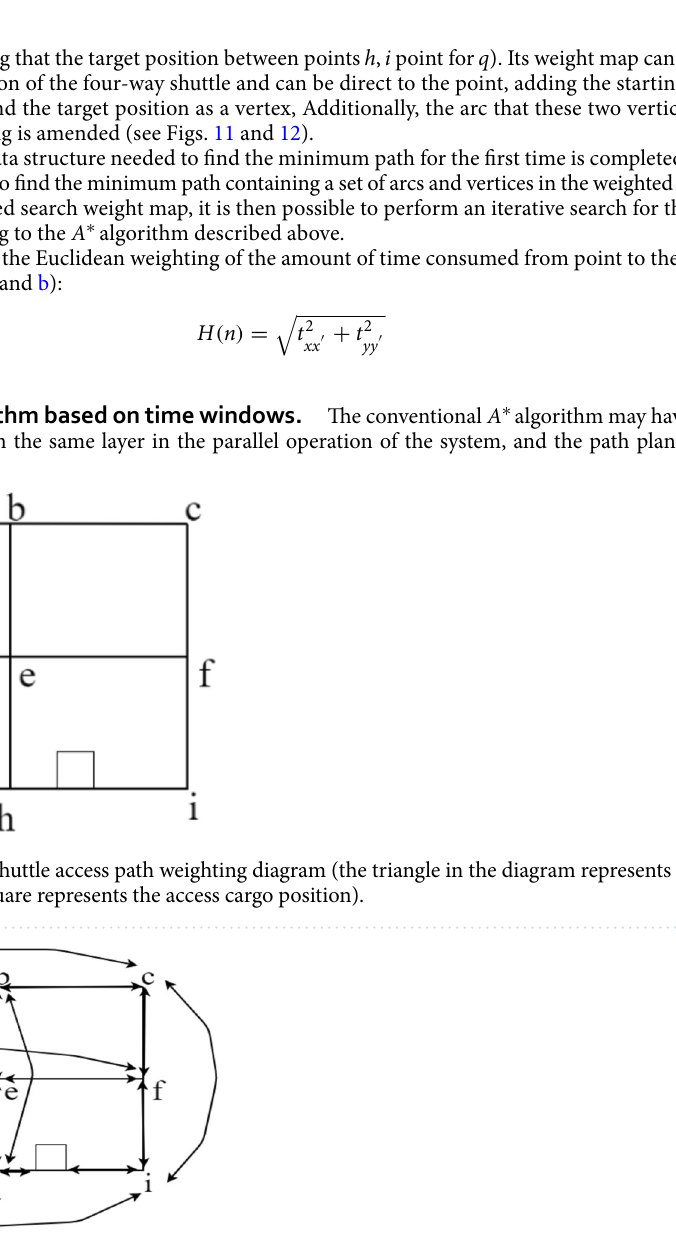
Figure 12. The path weights that the four-way shuttle can travel to access the goods can be used to find the minimum path containing a set of arcs and vertices in this weight map by the A*